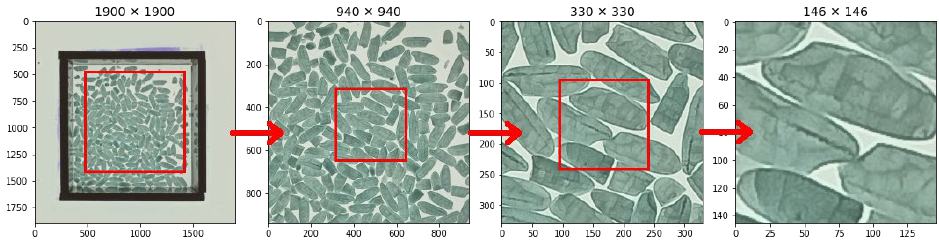
Figure 5. Cropping an image from G03 to evaluate global descriptors.